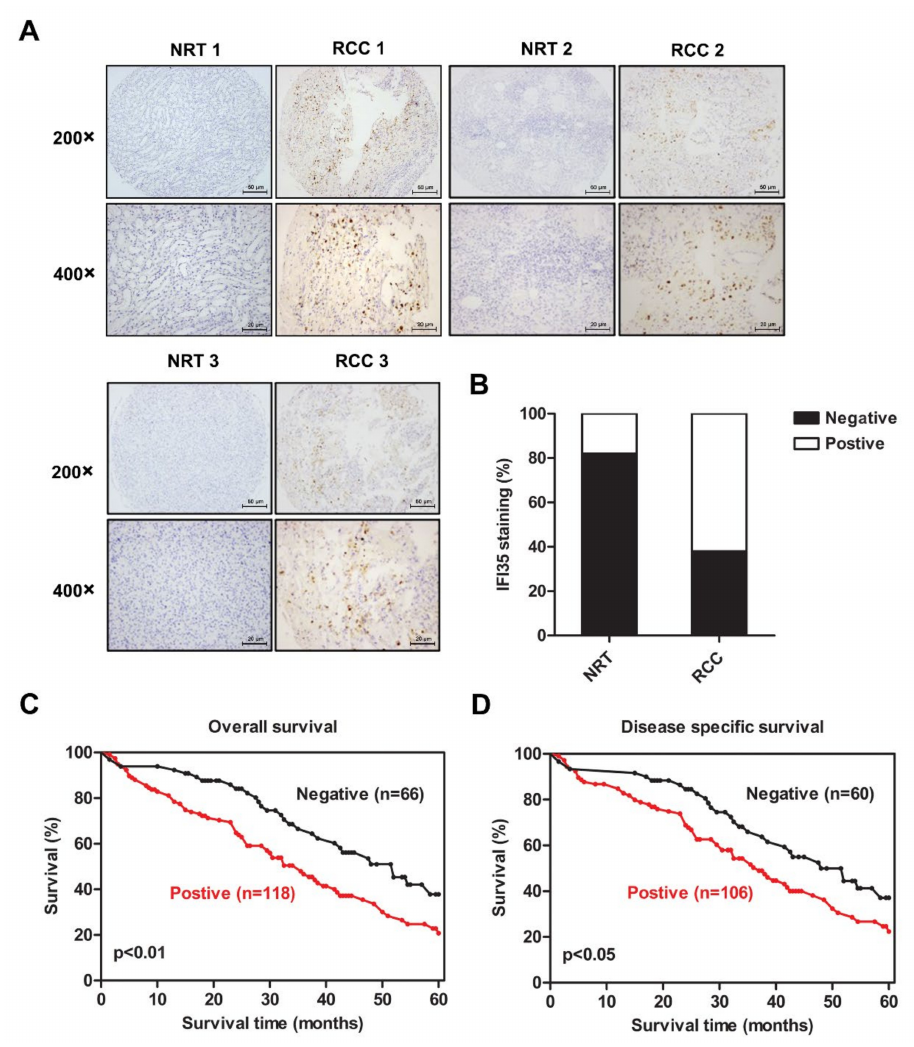
Figure 1. Higher IFI35 expression level was correlated with poor prognosis in RCC